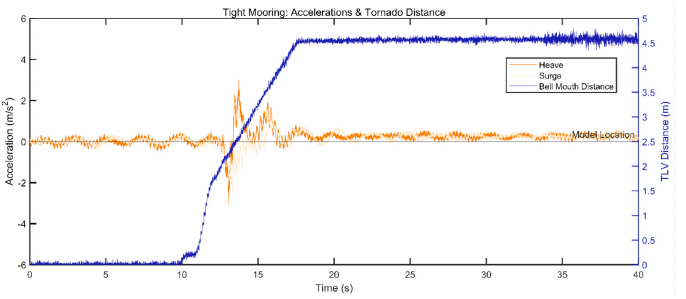
Figure 12. Heave and Surge accelerations and bell mouth distance (Tornado location) for configura- tion